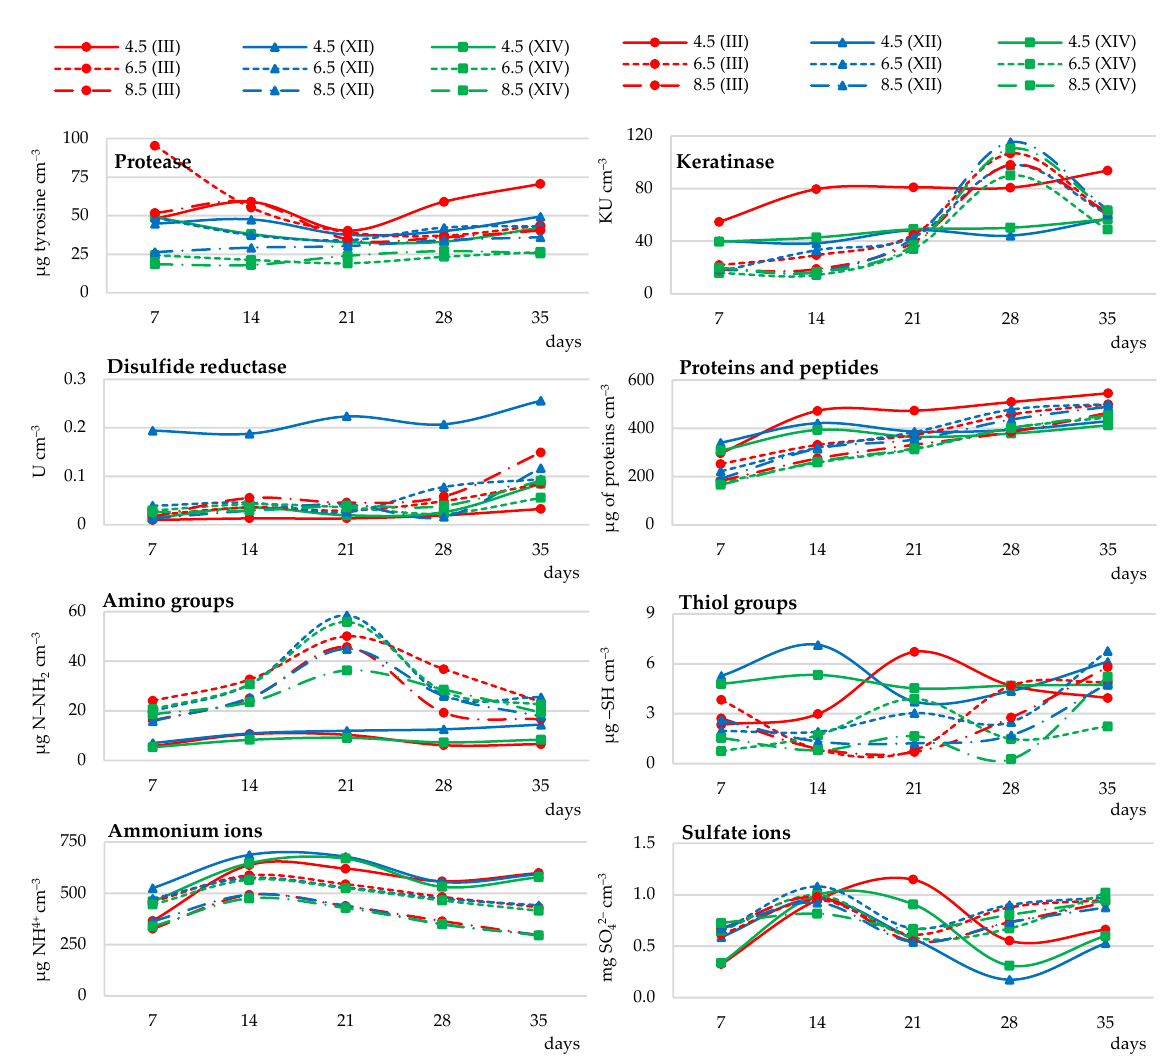
Figure 3. Dynamics of changes in enzymatic activity and released organic and mineral keratinolysis products in different initial medium pH values analyzed in cultures of three Trichophyton ajelloi strains III, XII, and XIV.